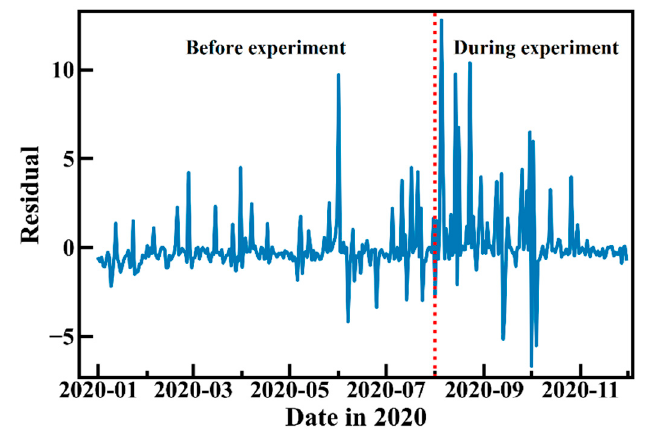
Figure 5. Residuals of daily precipitation in 2020.